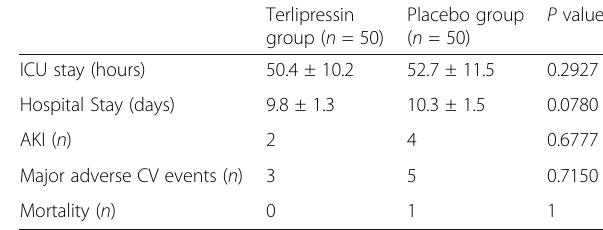
Table 6 Cardiac Index (L min − 1 ) Terlipressin group ( n = 50) Placebo group ( n = 50) P value